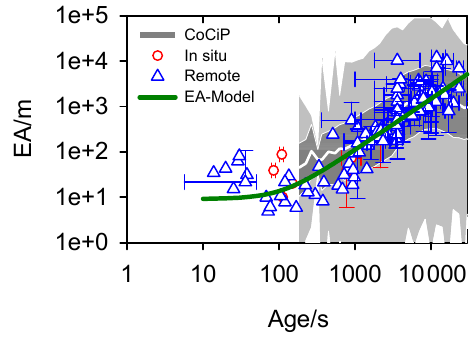
Figure 9. EA versus time: data (symbols as before) and a simple model (full dark-green